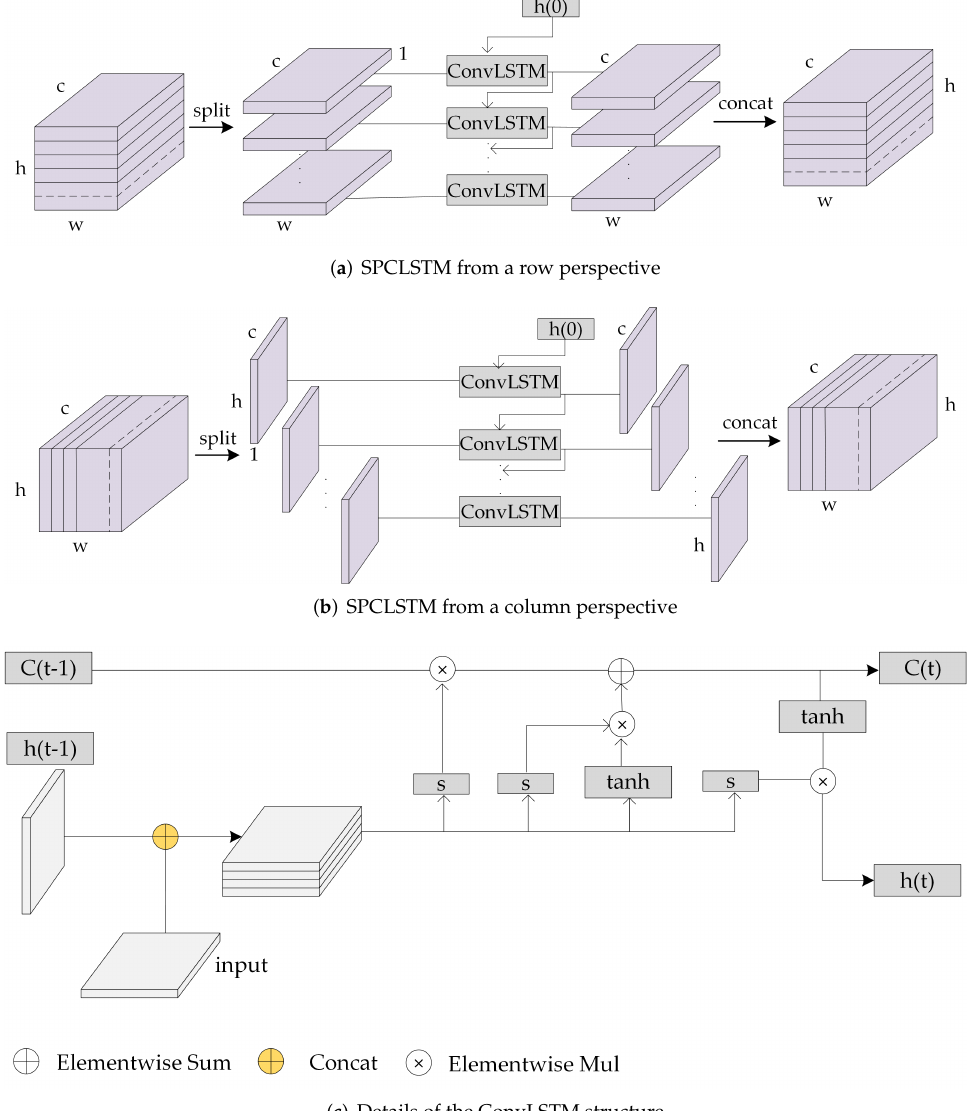
Figure 3. Details of the SPCLSTM structure. ( a ) The SPCLSTM module from a row perspective. ( b ) The SPCLSTM module from a column perspective. ( c ) The details of the ConvLSTM structure. c, h, and w denote the number of channels and the height and width of the feature map, respectively. ( c ) s represents the sigmoid function, and tanh represents the tanh function. h(t) represents the short- term memory at time t in the LSTM structure, while C(t) represents the long-term state preserved by the LSTM structure at time t in the cell structure. Elementwise Mul represents the product of two matrix corresponding position